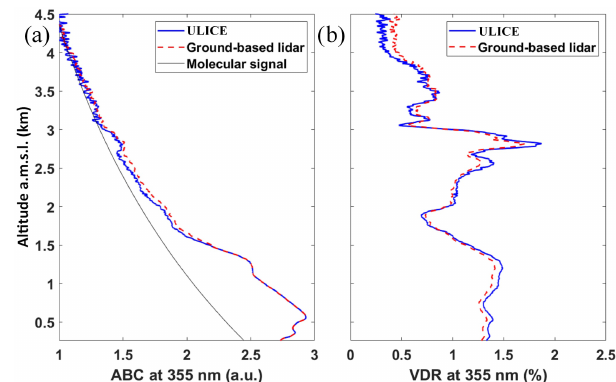
Figure 5. Vertical profiles of the (a) apparent backscatter coeffi- cient (ABC) and (b) volume depolarization ratio (VDR) derived from the ground-based N 2 -Raman lidar LAASURS and the lidar ULICE placed at ground level in zenith